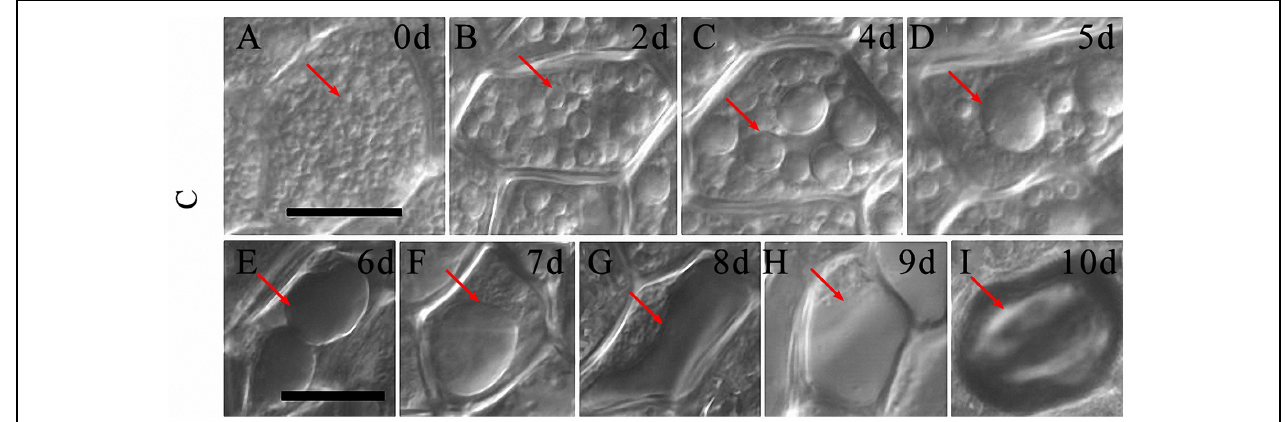
FIGURE 5 | The vacuolated process of aleurone cells treated with distilled water. (A–I) Vacuoles of aleurone cells treated with distilled water at 0, 2, 4, 5, 6, 7, 8, 9, and 10 days. The scale is 20 μ m.